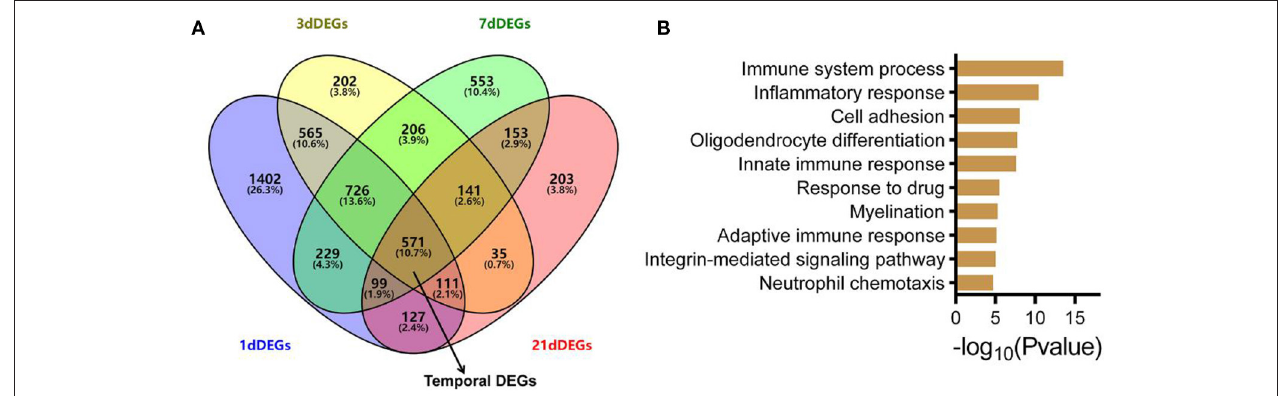
FIGURE 2 | ONC-induced temporal DEGs and the involved biological processes. (A) Venn plot of DEGs 1/3/7/21 d post-ONC. The temporal DEGs and overlap of the four DEGs are indicated by black arrows. (B) GO enrichment analysis for temporal DEGs showed the top 10 most enriched biological processes. GO, Gene Ontology; DEG, differentially expressed gene; ONC, optic nerve